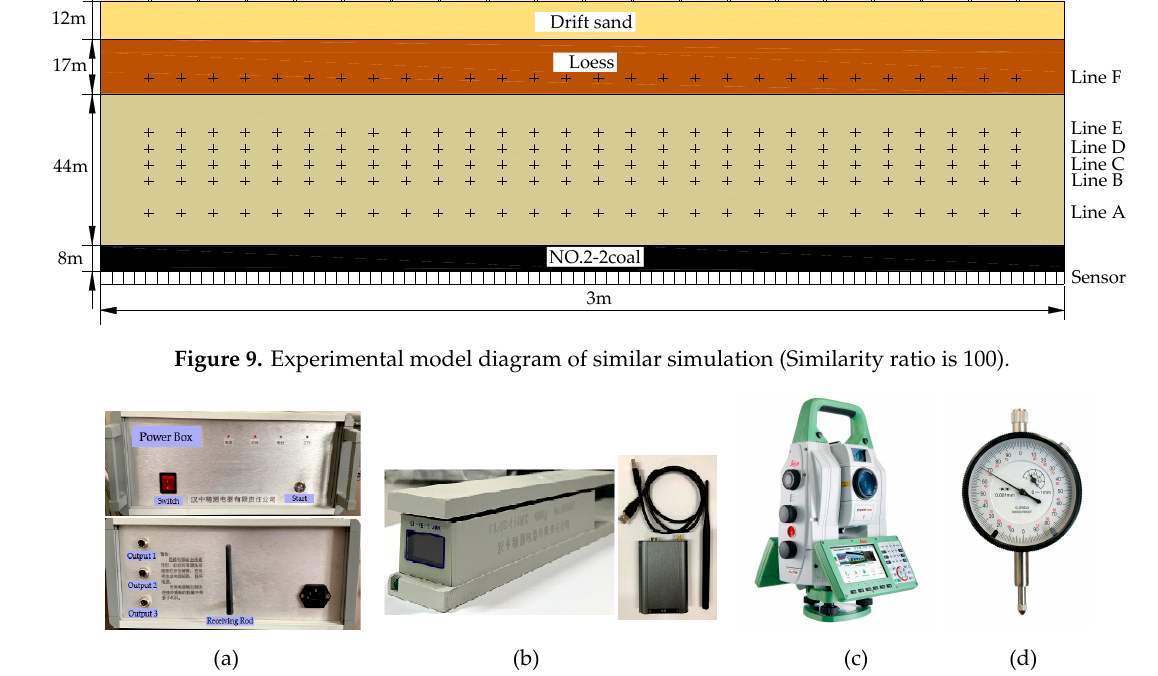
Figure 10. Experimental equipment: (a) Power box of wireless sensor; (b) Wireless sensor and receiver; (c) Total Station; (d) Dial indicator.